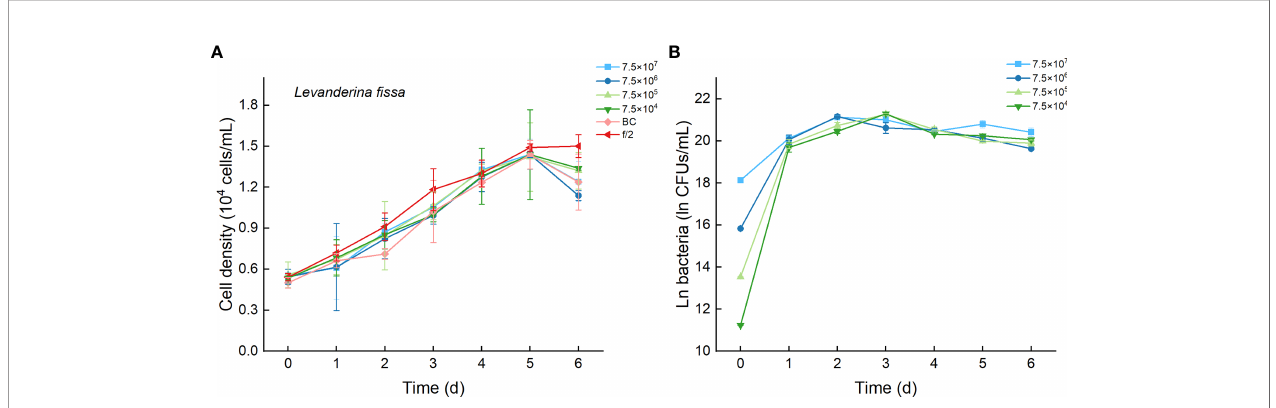
FIGURE 9 | The growth of Levanderina fi ssa in the co-cultures with different concentrations of bacterial strain Lf7 (7.5×10 4 -7.5×10 7 CFUs/mL). (A) Growth curves of L. fi ssa in co-cultures with Lf7, (B) Lf7 concentration in the algal